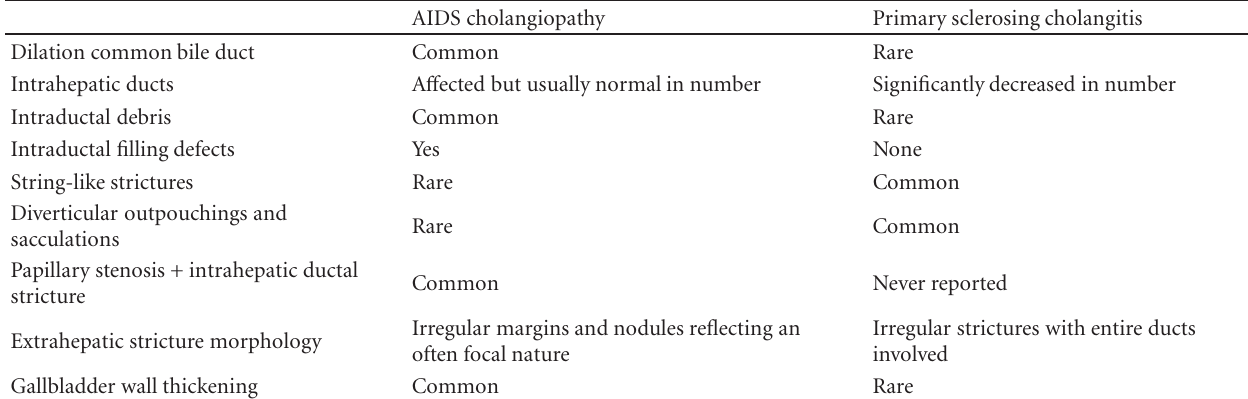
Table 2: Imaging features of AIDS cholangiopathy versus primary sclerosing